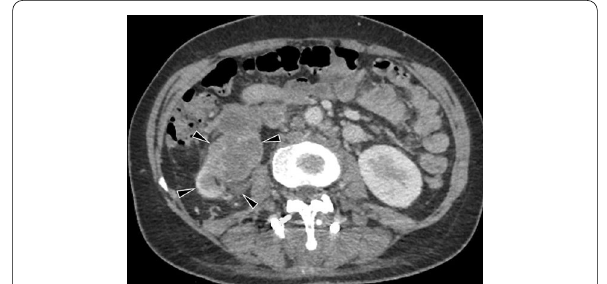
Fig. 36 Contrast-enhancement CT scan of a 48-year-old female with renal tuberculous show debris collection within dilated calyces and parenchymal destruction (with cortical thinning)